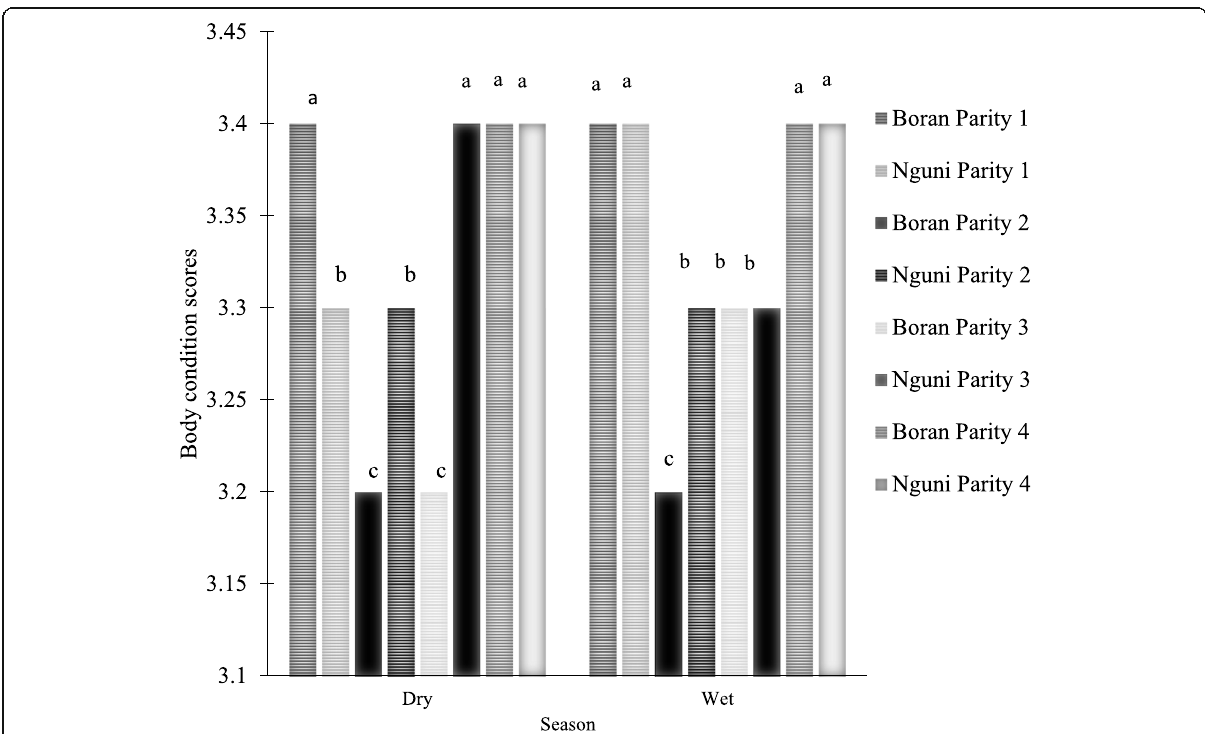
Figure 2 Seasonal changes in average body condition scores of Boran (herd 1) and Nguni (herd 2) cows in different